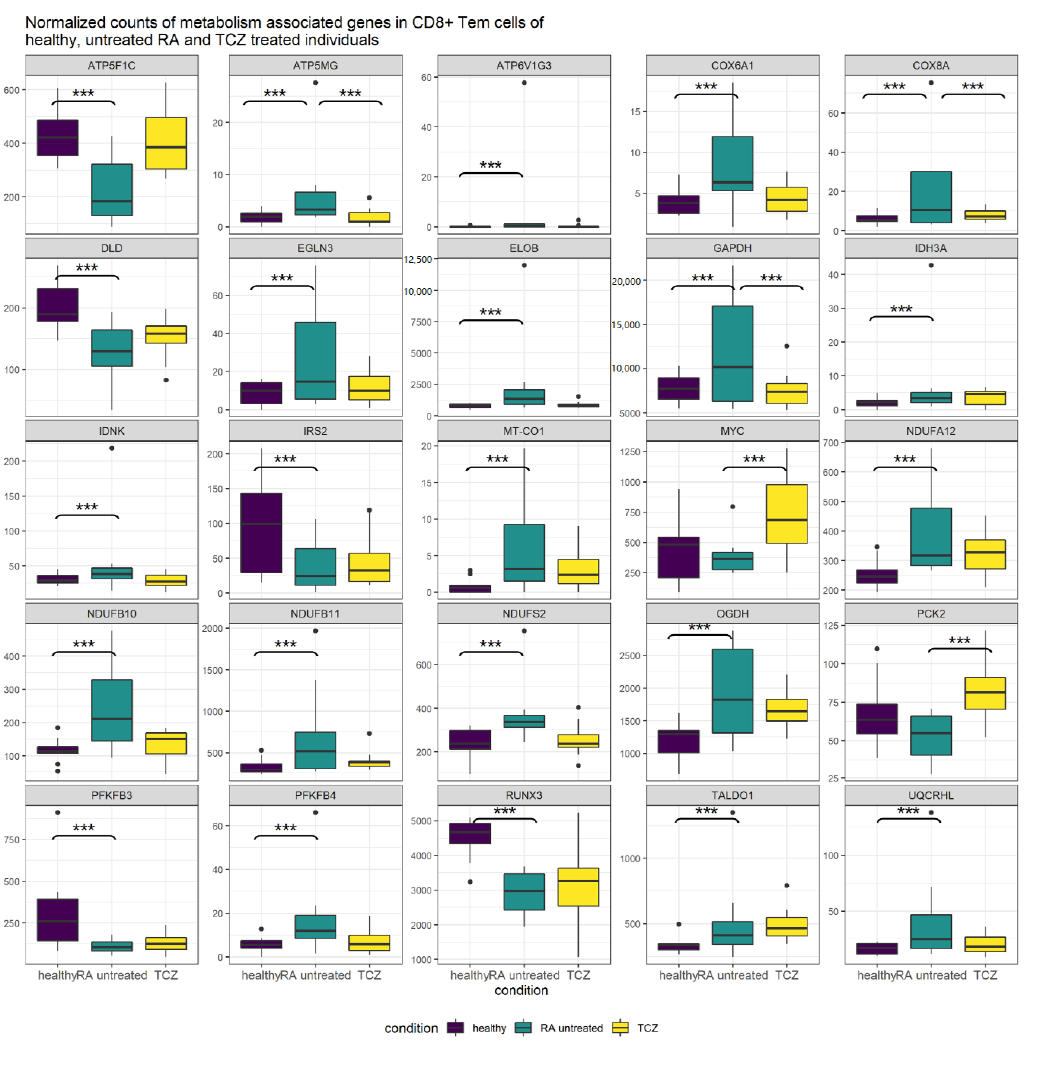
Figure 10. Normalized counts of genes associated with metabolic pathways or the regulation of glycolysis that show differential regulation in untreated RA CD8 + Tem cells or in TCZ-treated RA CD8 + Tem cells. Significant differential regulation is shown by asterisks